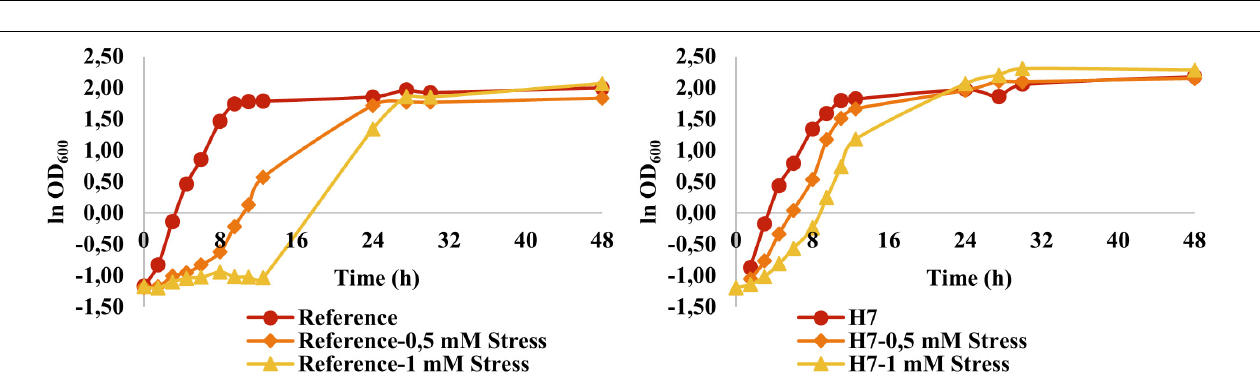
FIGURE 4 | Semi-quantitative cross-resistance analysis (spot assay) results of H7 and the reference strain, upon 72 h of growth. The strains were cultured on YMM plates containing various stress factors, at four serial dilutions (10 - 1 to 10 - 4 ). YMM plates without any stress factor were used as the control.